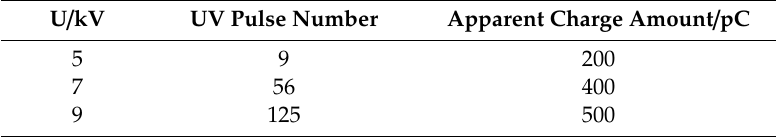
Table 4. Detection pulse number of UV detection and the apparent charge amount of the circuit. U /